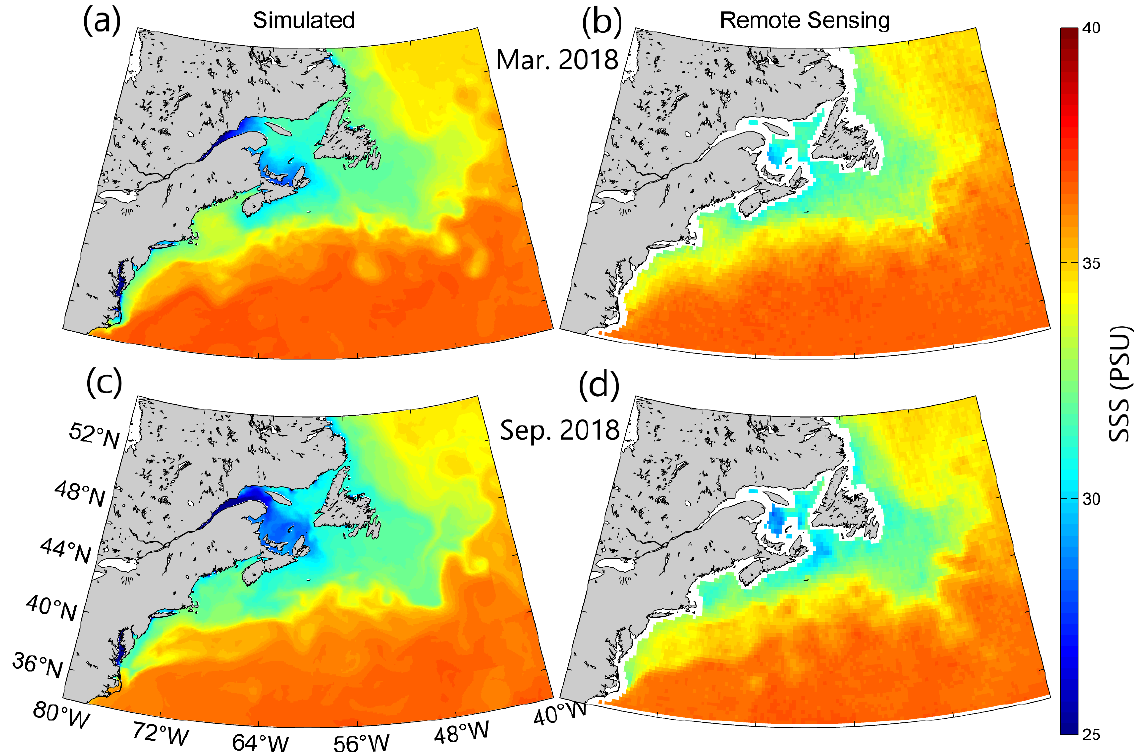
Figure 6. The monthly-mean sea surface salinity (SSS) over the L1 domain in ( a , b ) March and ( c , d ) September 2018 from ( a , c ) the results of submodel L1 and ( b , d ) SSS remote sensing data. The simulated monthly-mean SSS in September 2018 ranges from 25 to 29 over most of the western GSL and coastal waters off Cape Breton Island (CBI). Over the western GSL and coastal waters off CBI, the monthly-mean SSS is lower in September than in March 2018. Previous studies have demonstrated that the SSS in the GLS, ScS, and GoM is significantly affected by the discharge from major rivers in the region, including the SLR. The monthly-mean SLR discharge data constructed by the SLGO for the period December 2017–December 2018 were largest during March–June 2018 (1.3~1.8 × 10 4 m 3 s − 1 ). Ohashi and Sheng [41] demonstrated that the freshwater signal from the SLE takes about 100 days to reach Cabot Strait. Therefore, the relatively low SSS over the western GSL and off CBI in the summer (relative to the winter) in 2018 is due mainly to the seaward transport of the large SLR discharge during the spring season (particularly between March and June). In addition, the stronger vertical stratification in the summer than in the winter also partially contributes to the seasonal SSS differences between winter and